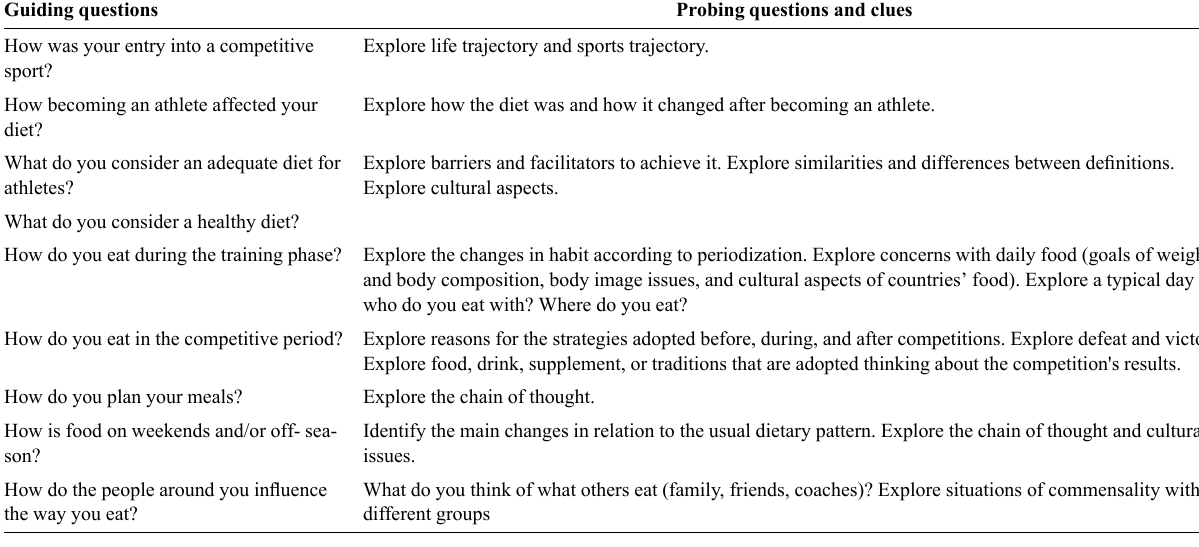
Table 2 - Guiding and probing questions and clues Guiding questions Probing questions and